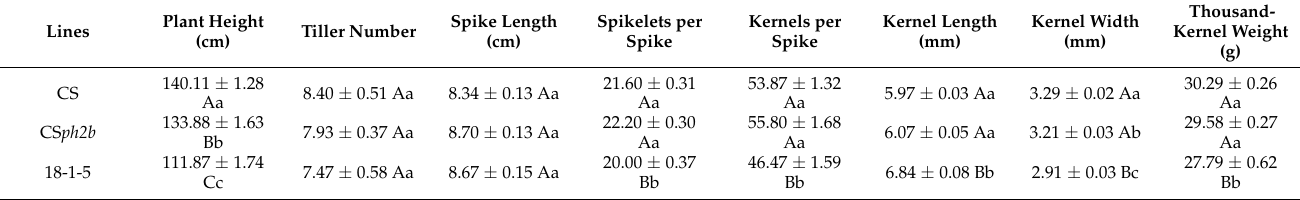
Table 1. The agronomic performance of 18-1-5, and its wheat parents CS and CS ph2b